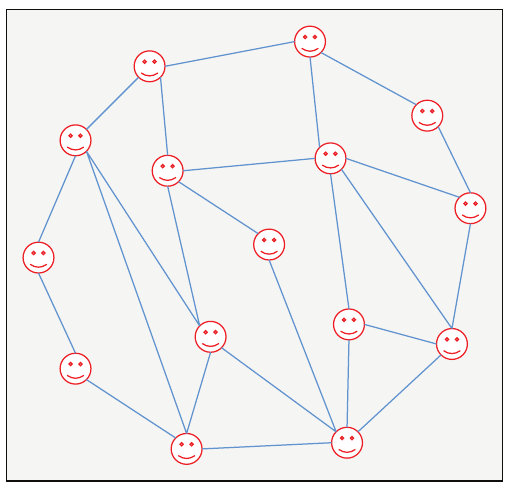
Figure 10: Fully-connected network, adapted from Ross et al. [135].